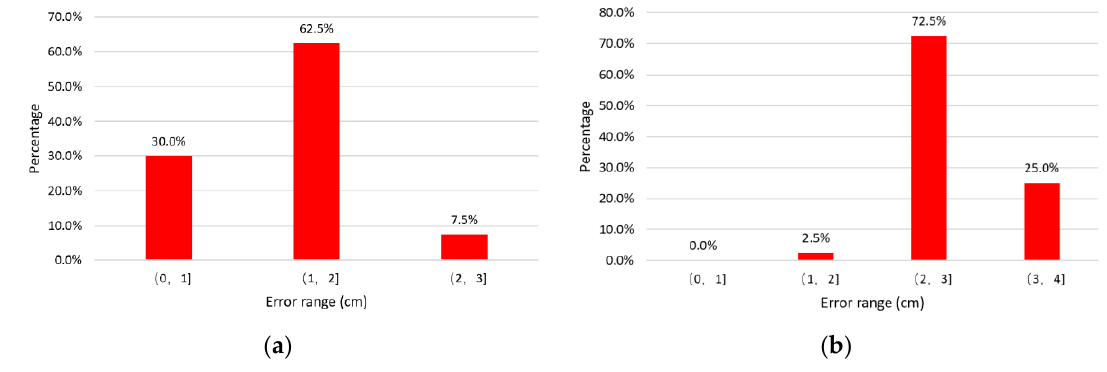
Figure 15. Positioning error distribution : ( a ) with the offset range of 1–10 cm; ( b ) with the offset range of 16–25 cm.